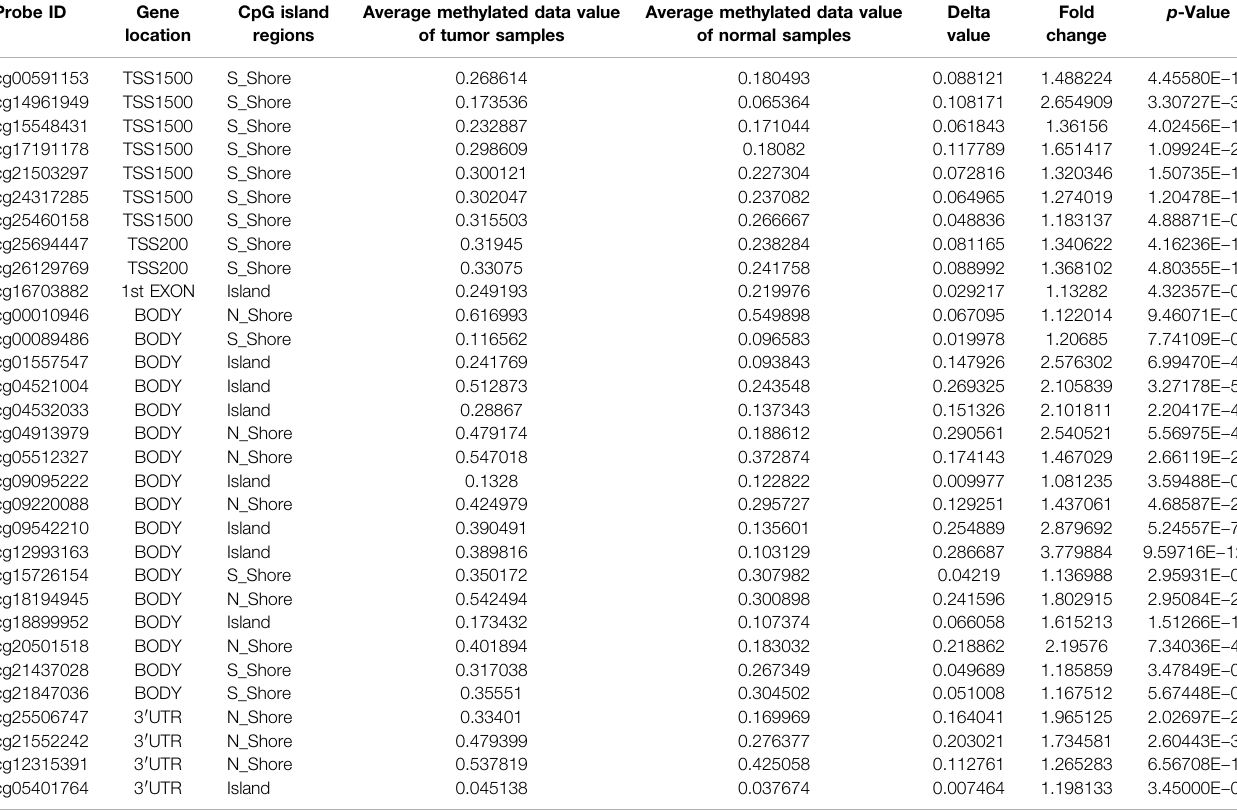
TABLE 1 | Differential methylation levels of the SHOX2 probe between LUAD and normal samples. Probe